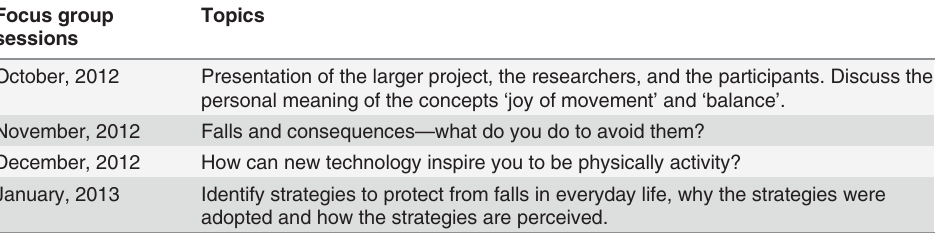
Table 2. Topic guide for the focus group